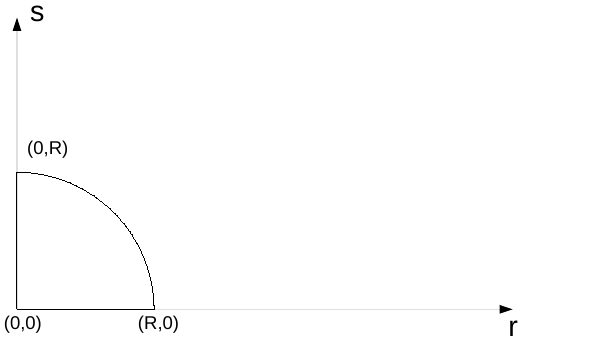
Figure 1 . s vs. r plot for a static black hole with radius R ( b = 0